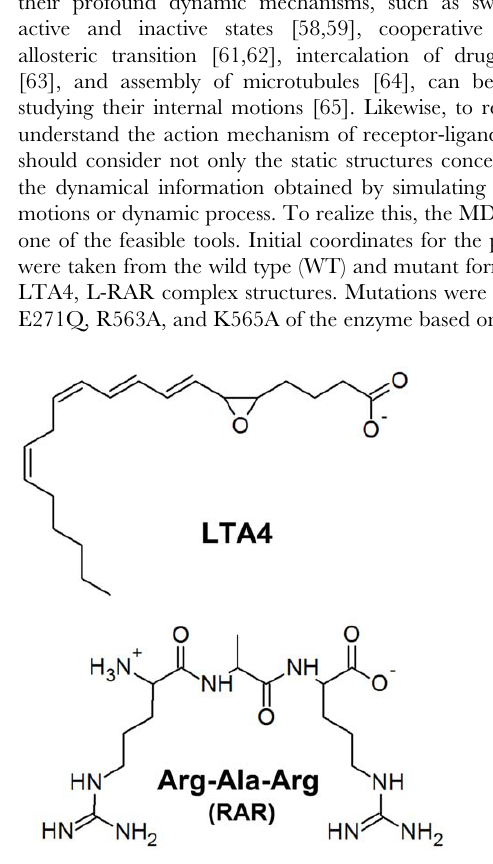
Figure 2. The 2D structures of two diverse substrates of bifunctional enzyme,